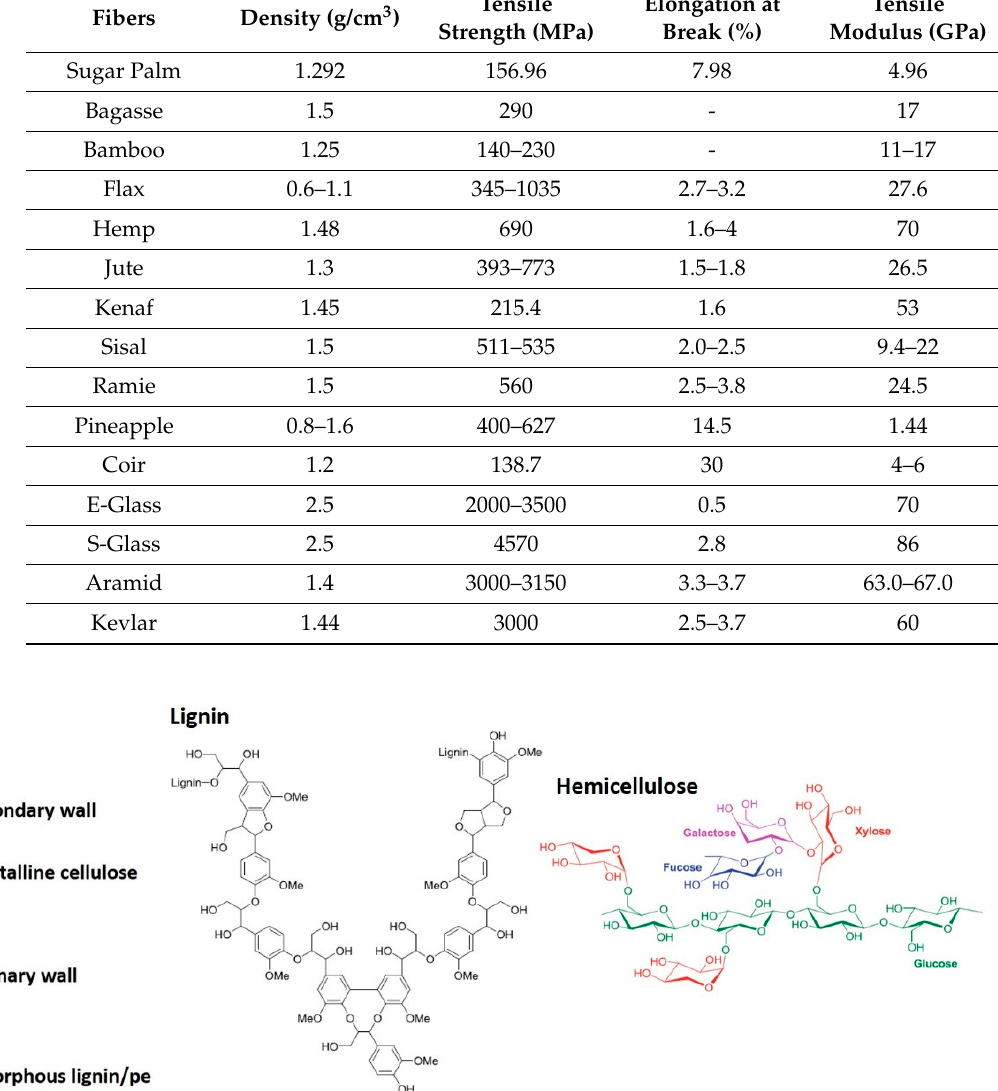
Table 2. Physical and mechanical performance of natural fiber vs. synthetic fiber.